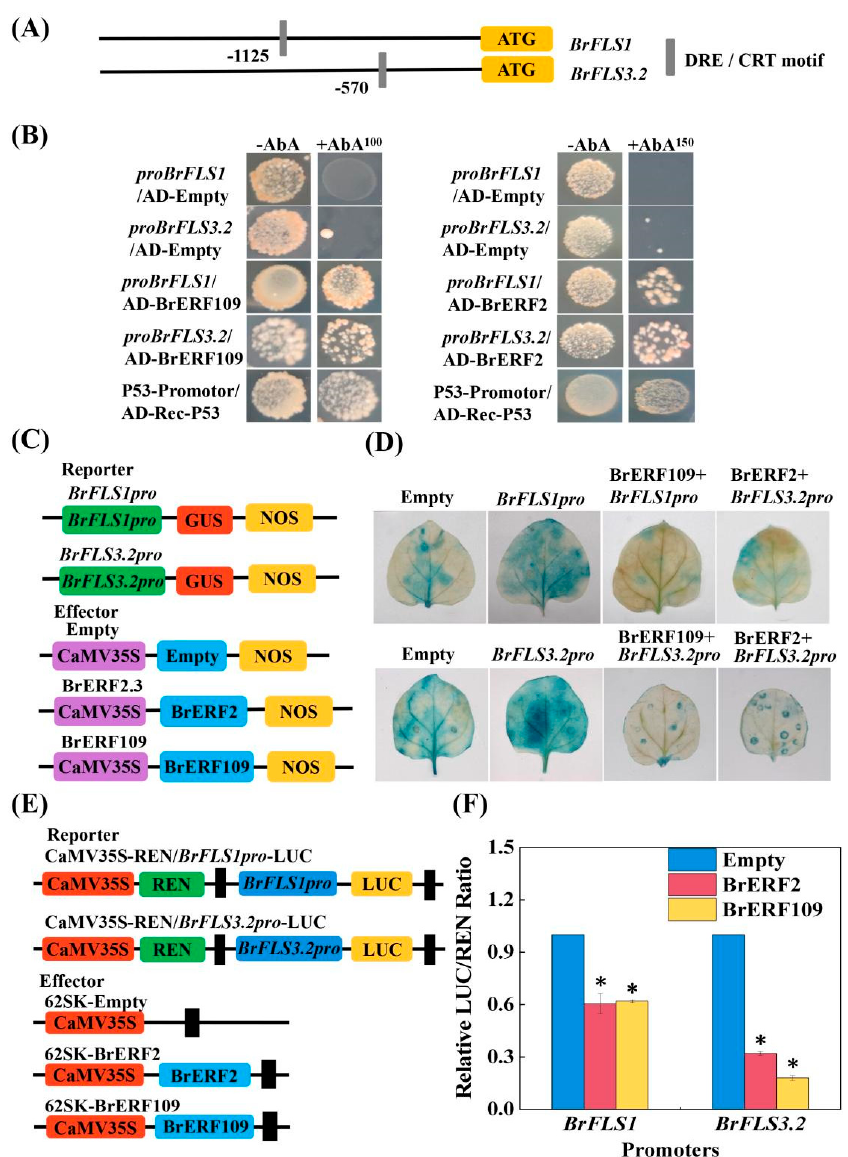
Figure 5. BrERF2 and BrERF109 directly bind to the promoter of BrFLS1 and BrFLS3.2 , respectively. ( A ), Promoter schematic diagram of flavonoid biosynthesis genes. ( B ), Y1H analysis indicated that BrERF2 and BrERF109 could directly bind to the promoter of BrFLS1 and BrFLS3.2 , respectively. ( C ), Schematic diagram of reporter and effector genes used for GUS staining. ( D ), GUS staining analysis showed that BrERF2/BrERF109 inhibited the expression of BrFLS1 and BrFLS3.2, respectively. ( E ), Schematic diagram of reporter and effector genes used for LUC assay. ( F ), Relative LUC/REN ratio indicated that the transcription levels of BrFLS1 and BrFLS3.2 were suppressed by Br- ERF2/BrERF109. The asterisks above columns indicate a significant difference at * p < 0.05. Each value indicates the mean ± SD of six biological